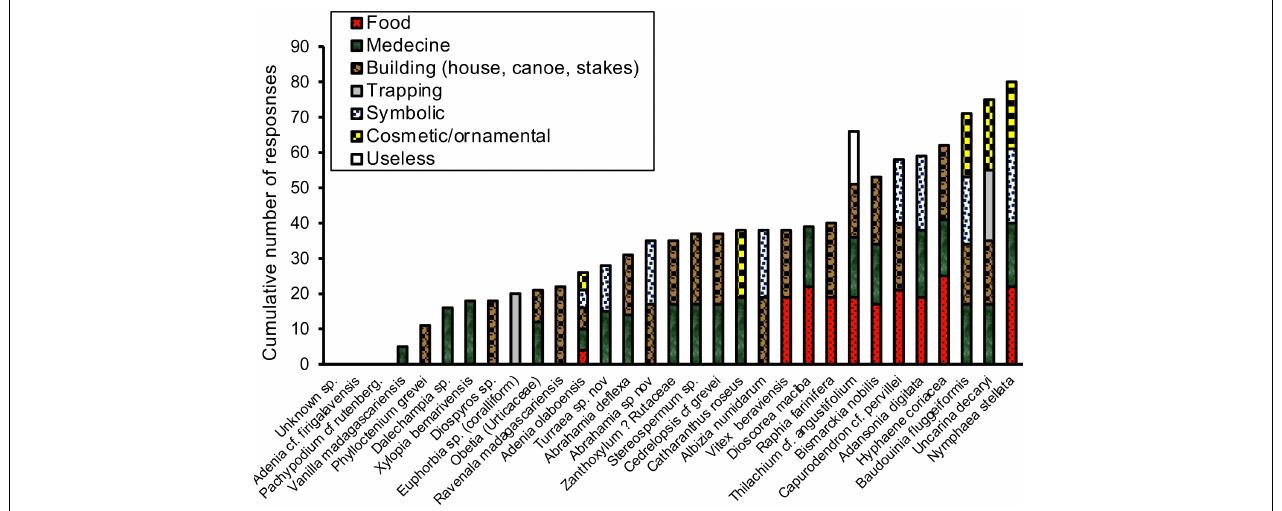
FIGURE 5 | Spontaneous declarative responses with respect to plant use for each plant species presented as a picture in 26 Antrema inhabitants (same panel as in Figure 4 ). The various uses of the vegetative or reproductive plant parts have been grouped for easier